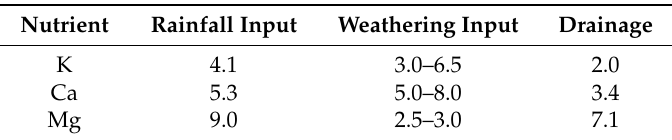
Table 4. Nutrient inputs through rainfall and weathering of minerals and output through drainage in Spain (kg ha ´ 1 year ´ 1 ) by Dambrine et al.